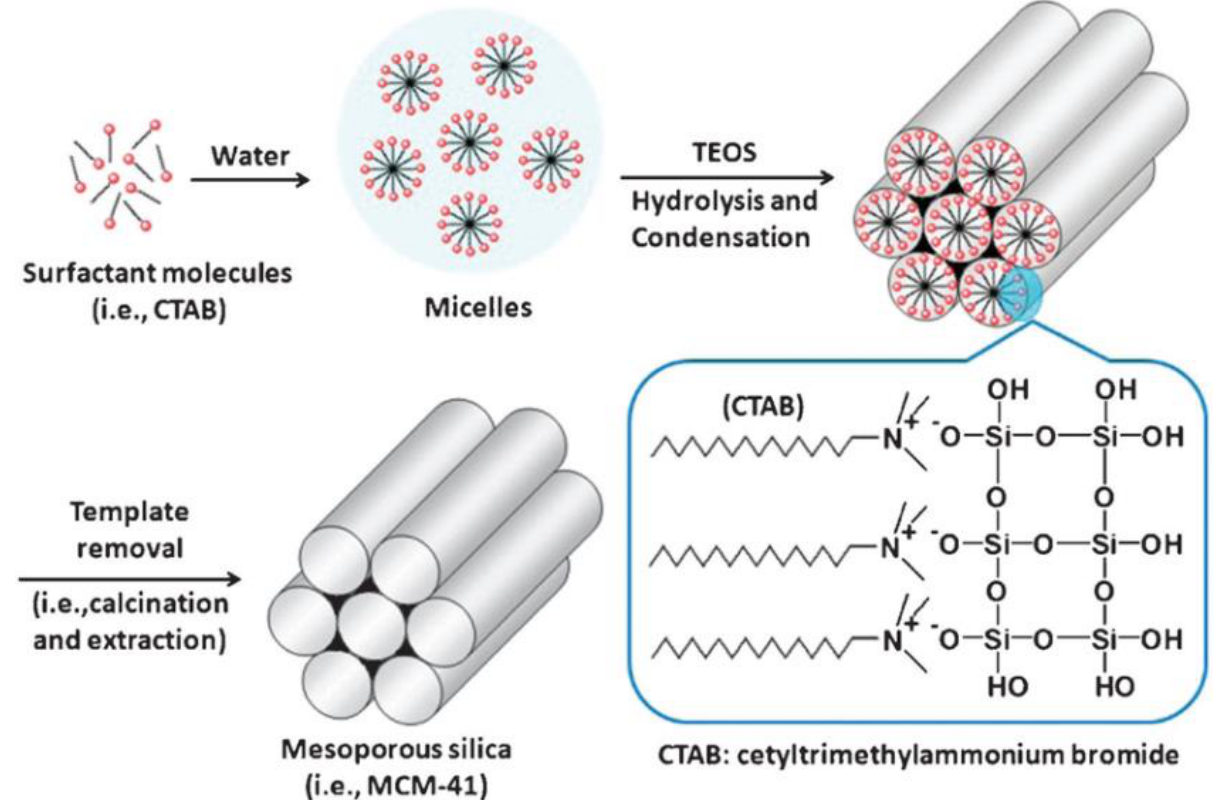
Figure 4. Schematic representation of the mechanism of formation of MCM-41 using cetyltrime- thylammonium bromide (CTAB) as cationic surfactant [48]. Copyright © 2022, Royal Society of Chemistry.